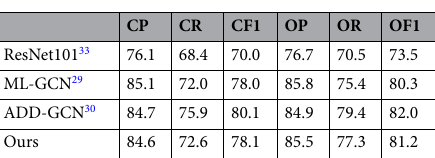
Table 2. Comparison of performance (%) on COCO